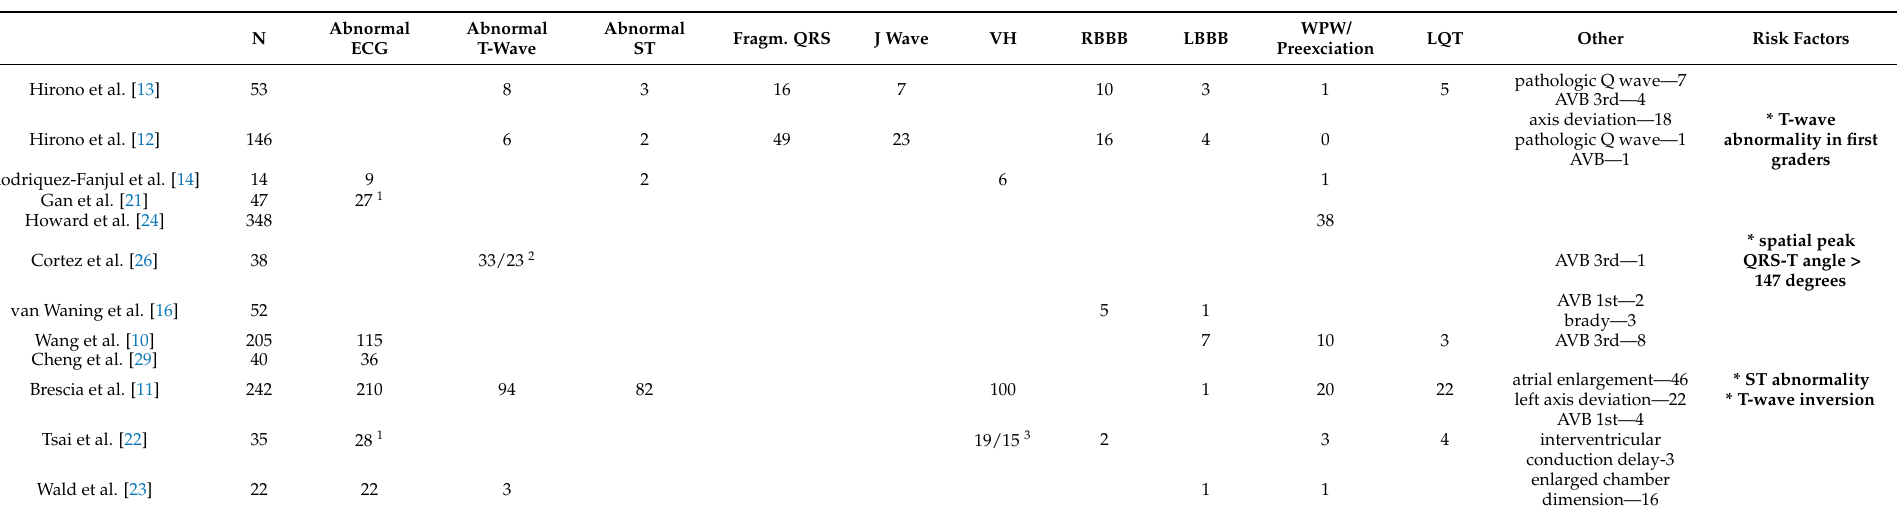
Table 3. Most common ECG abnormalities and risk factors for unfavorable